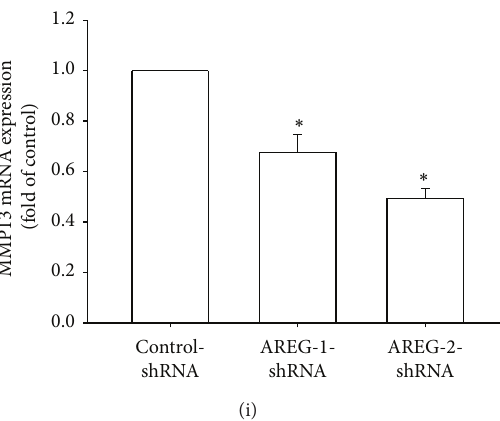
Figure 1: Concentration- and time-dependent increases in MMP-13 production by AREG. ((a) and (b)) Human synovial fibroblasts were obtained from normal (𝑛 = 3) or osteoarthritis patients (𝑛 = 3) and examined by Western blot and qPCR for the expression of AREG. (c) OASF and normal SF were incubated with AREG for 24 h. The mRNA expression of MMPs was examined by qPCR (𝑛 = 4) . ((d) and (e)) OASF and normal SF were incubated with various concentrations of AREG for 24h or with AREG (50ng/mL) for 6, 12, or 24 h. The mRNA expression of MMP-13 was examined by qPCR (𝑛 = 4) . ((f) and (g)) OASFs were incubated with various concentrations of AREG for 24 h or with AREG (50 ng/mL) for 6, 12, or 24 h, and supernatants and cell lysates were then collected. MMP-13 protein levels in cell lysates were determined by Western blot analysis. MMP-13 enzymatic activity in cell lysates and supernatants was measured using zymography. Both protein levels and enzymatic activity increased in a time-dependent manner (𝑛 = 4) . (h) The protein and mRNA levels of AREG and MMP-13 in control-shRNA and AREG-shRNA OASF were examined by Western blot and qPCR. Results are expressed as the mean ± SEM. ∗ 𝑃 < 0.05 compared with control; # 𝑃 < 0.05 compared with AREG-treated